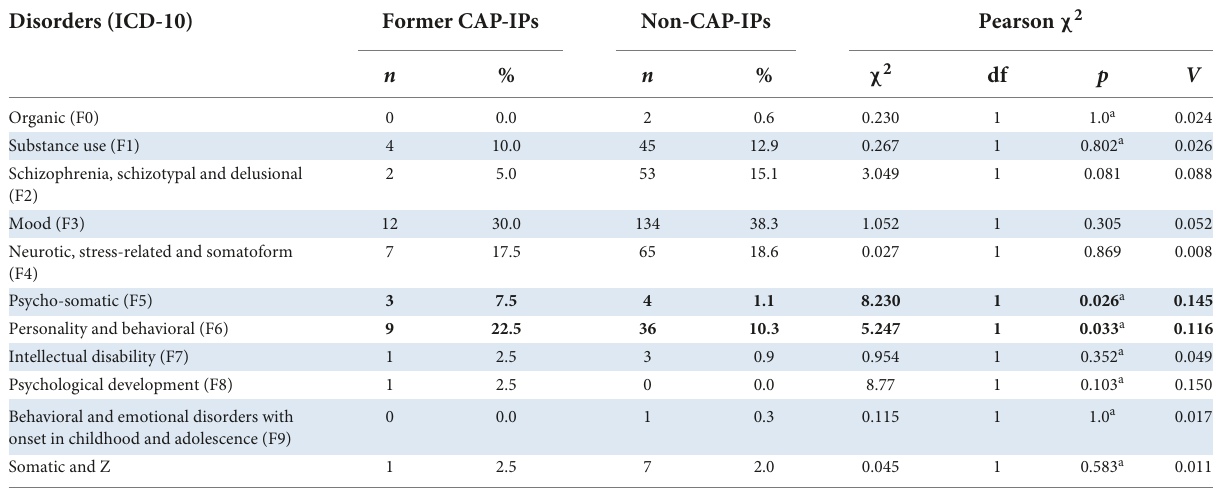
TABLE 4 Comparison of the primary ICD-10 diagnosis received at last psychiatric inpatient treatment ( n , %, Pearson χ 2 ) in young adult inpatients with a former child- and adolescent psychiatric inpatient treatment (former CAP-IPs) and those without it (non-CAP-IPs). Disorders (ICD-10)